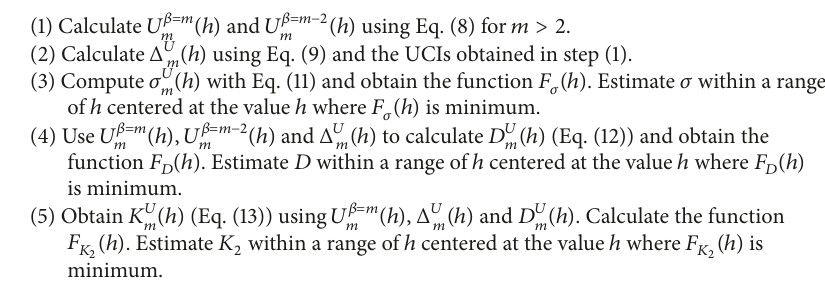
Algorithm 1: Automated estimation of attractors’